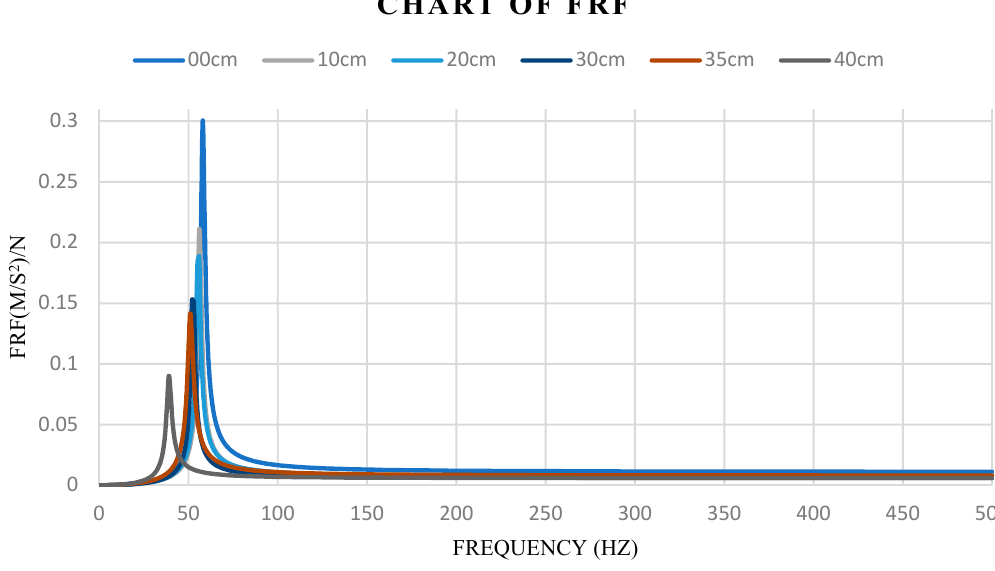
Figure 12. The frequency response function (FRF) change.